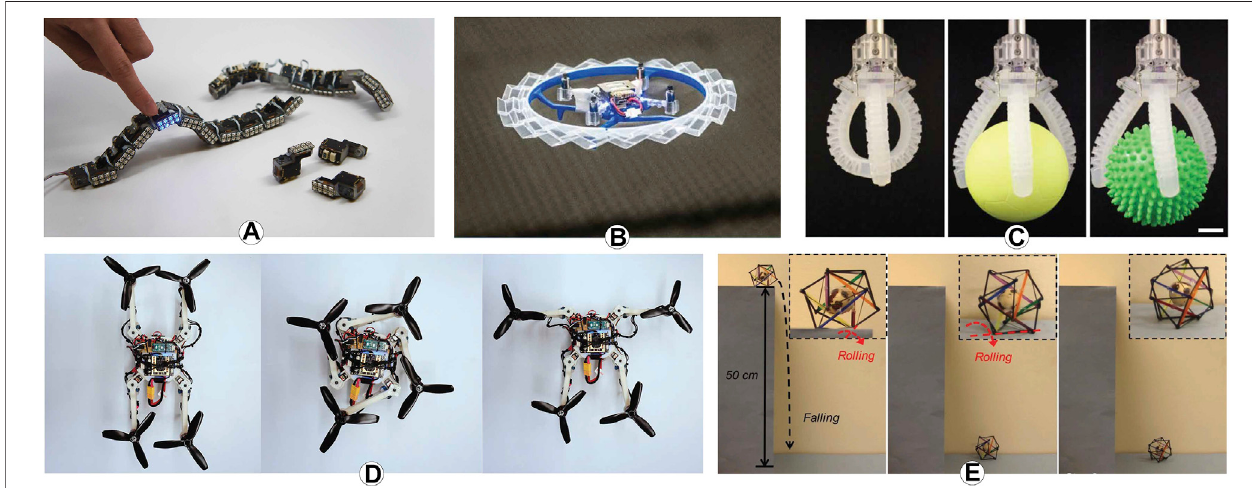
FIGURE 3 | Examples of robots with shape-changing technologies, including (A) modular robots in ChainFORM (Nakagaki et al., 2016a), (B) origami structures in Rotorigami(Sarehetal.,2018), (C) softmaterials(Trubyetal.,2018), (D) deployablestructuresthatenablefolding,expansion,andcontraction(Falangaetal.,2018),and (E) tensegrity systems (Wang et al.,